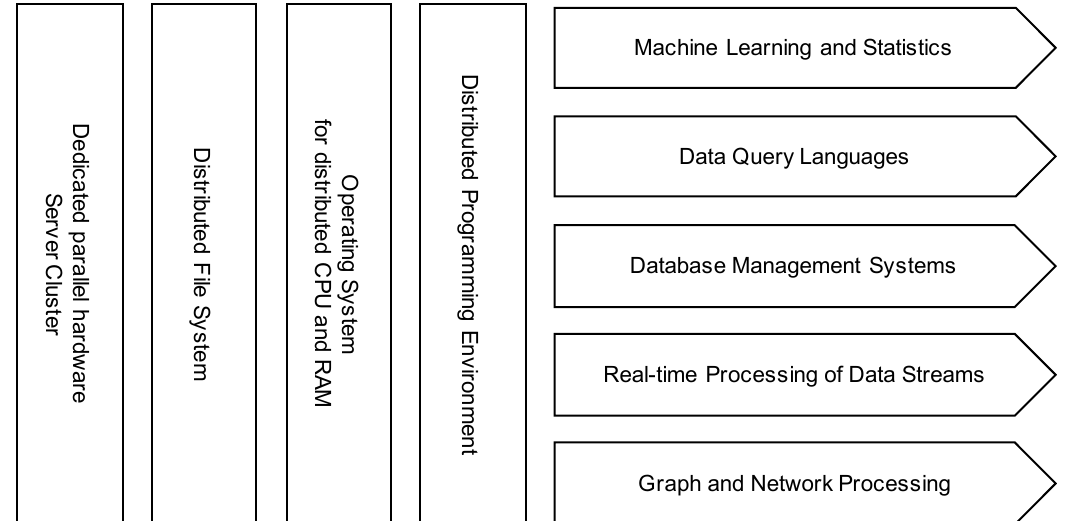
Figure 1. Big data technology model, abstracted from The Hadoop Stack and the Berkeley Data Analysis Stack described by Singh & Reddy [15].